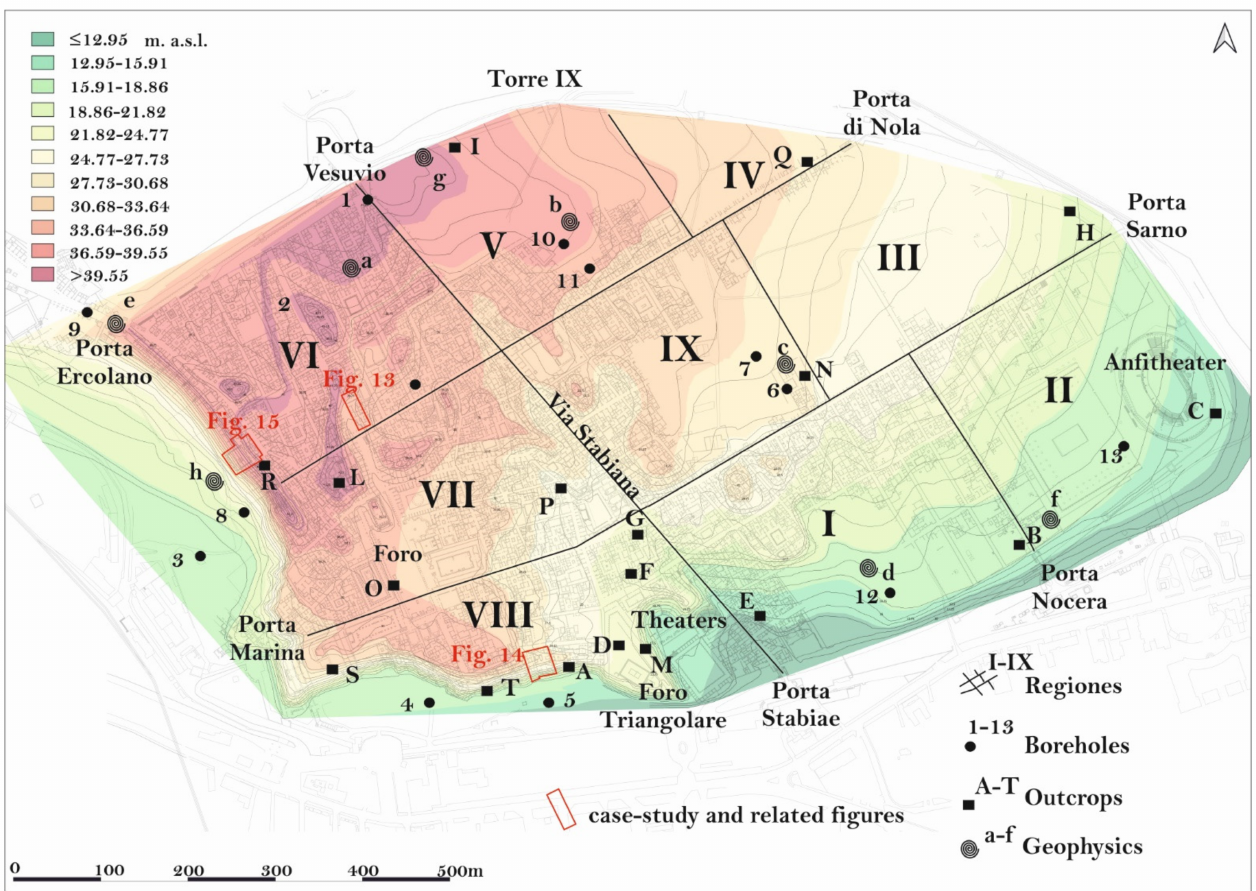
Figure 5. Digital terrain model (DTM) of the Pompeii archaeological area with location of the available data (boreholes, outcrops and geophysical surveys). Also, locations of the case-studies highlighted in the Discussion section are